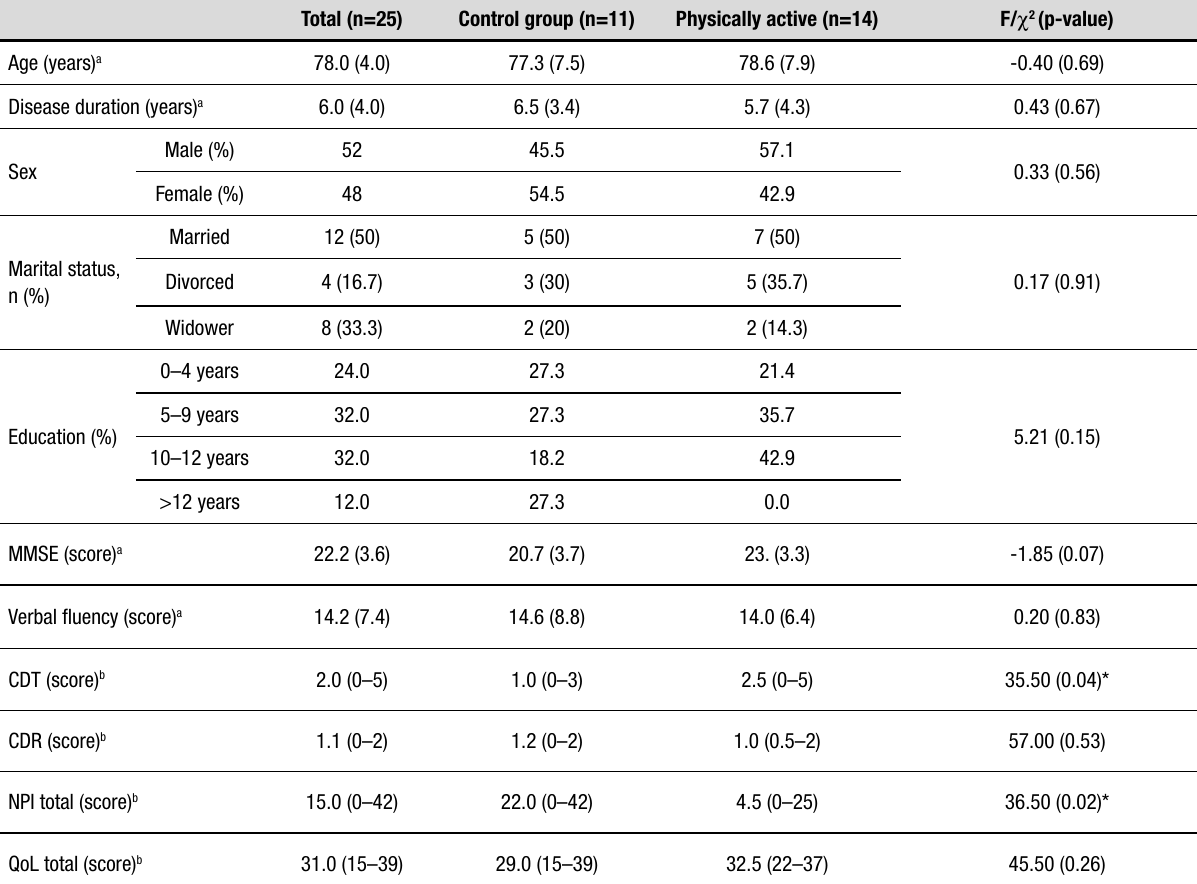
Table 1. Demographic and clinical characteristics by